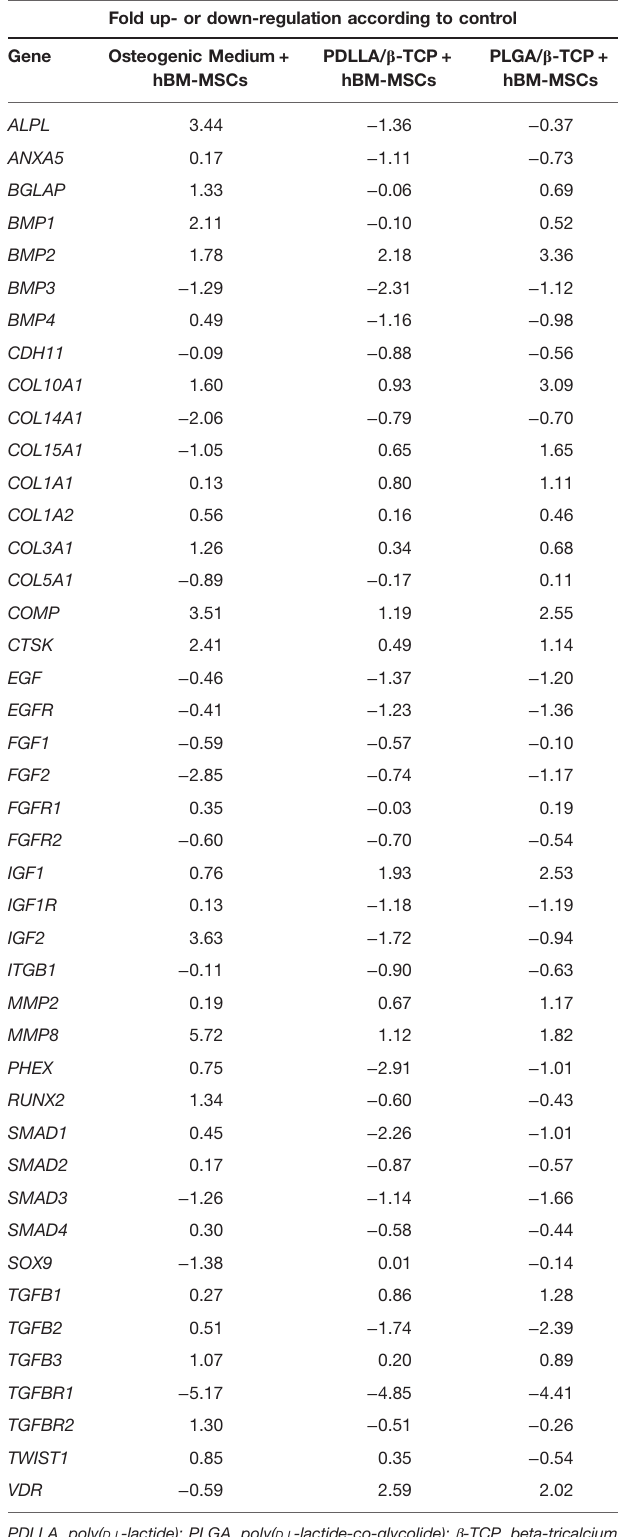
TABLE 2 | The upregulation or downregulation of genes in the test groups according to control. Fold up- or down-regulation according to control Gene Osteogenic Medium+